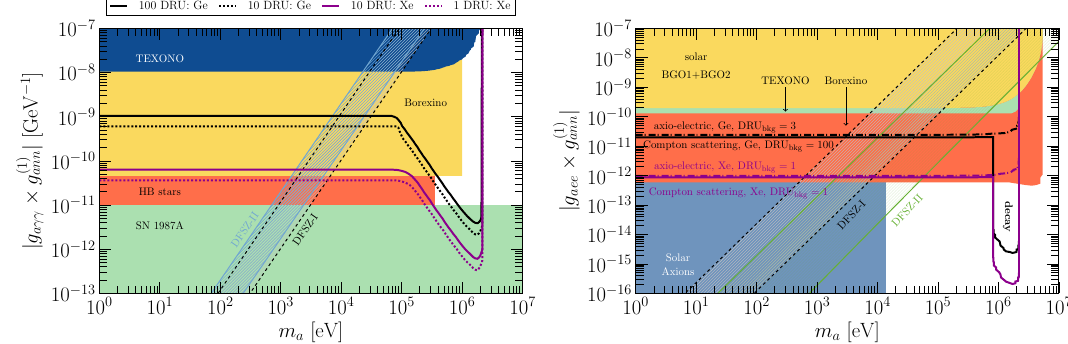
Figure 12 . Left graph : photon-ALP times nucleon-ALP couplings 90% CL sensitivities along with relevant laboratory and astrophysical limits in the region of interest. Black contours correspond to 90% CL sensitivities achievable with ongoing or near-future experiments (see table 3). Purple contours instead indicate 90% CL sensitivites that could be achieved in a next-generation xenon de- tector. Solid (dotted) contours refer to sensitivities under the assumption of different background rates (see the legend). Right graph : same as in left graph but for electron-ALP times nucleon- ALP couplings sensitivities. Here solid (dot-dashed) curves correspond to detection via inverse Compton-like scattering and decays into electron-positron pairs (axio-electric absorption), with dif- ferent background rates. The solar axion region includes limits from EDELWEISS III, MAJORANA DEMONSTRATOR, CDEX and PandaX-II [121, 127–129]. For completeness we include the region of DFSZ-I and DFSZ-II QCD axion